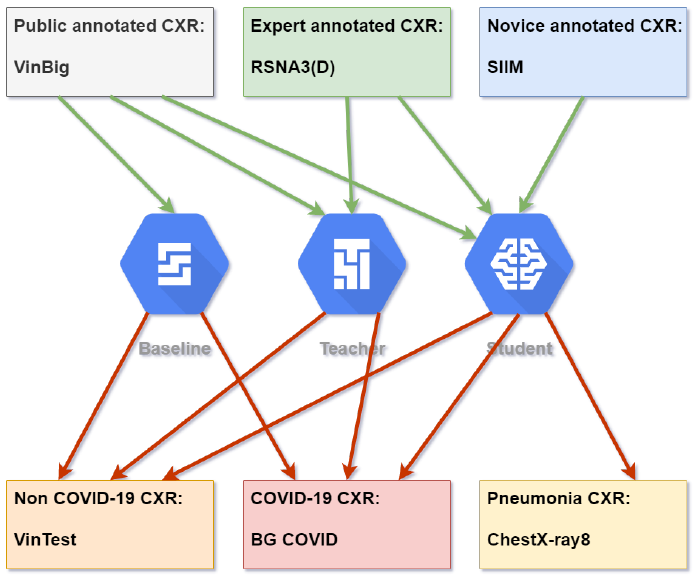
Figure 2. Train and test data on three models in our